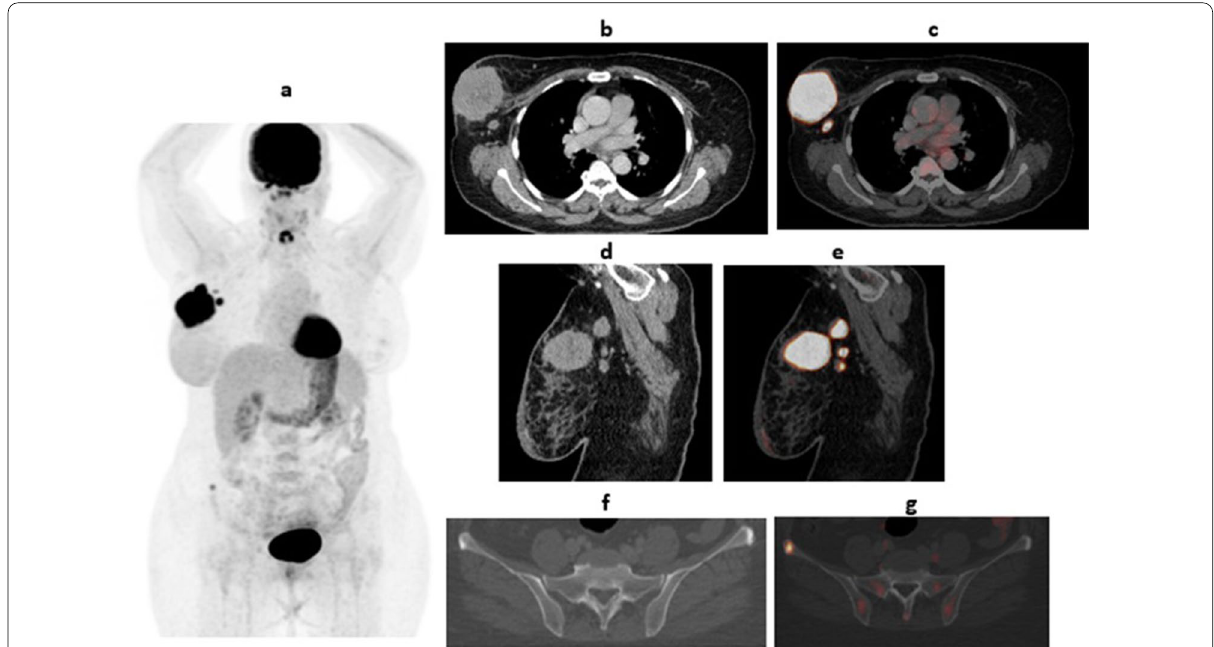
Fig. 6 A 61-year-old female patient presented with recently diagnosed right breast cancer (invasive ductal carcinoma). a Whole-body PET MIP image revealed large active right breast mass with multiple active ipsilateral axillary LNs as well as other less active right pelvic bone focus. b , c , d , e axial and sagittal CECT and fused PET/CT images revealed large right breast heterogeneously enhancing hypermetabolic upper outer quadrant mass, measuring 77 56 66 mm and achieving 23 SUVmax as well as multiple enlarged hypermetabolic right axillary lymph nodes, the largest × × measures 23 24 26 mm and achieving 20.5 SUVmax. f , g axial pelvic CT and fused PET/CT images (bone window) revealed small metabolically × × active right iliac bone deposit in fused PET/CT image, achieving 6 SUVmax, not appreciated in CT image alone